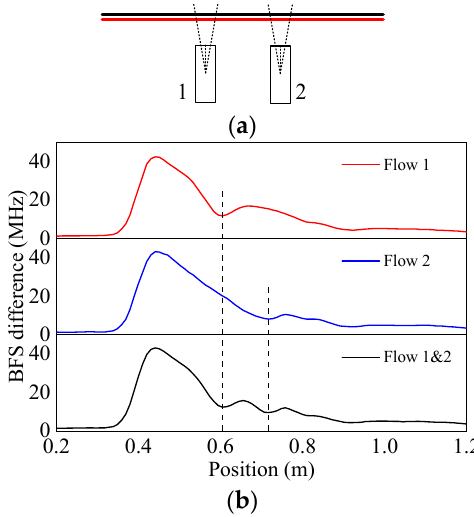
Figure 5. Schematic diagram and measurement results for two airflows blowing simultaneously: ( a ) Schematic diagram of two airflows blowing simultaneously; ( b ) Distributions of BFS difference when the sensing fiber was blown by airflow 1 (red), 2 (blue) and both (black).